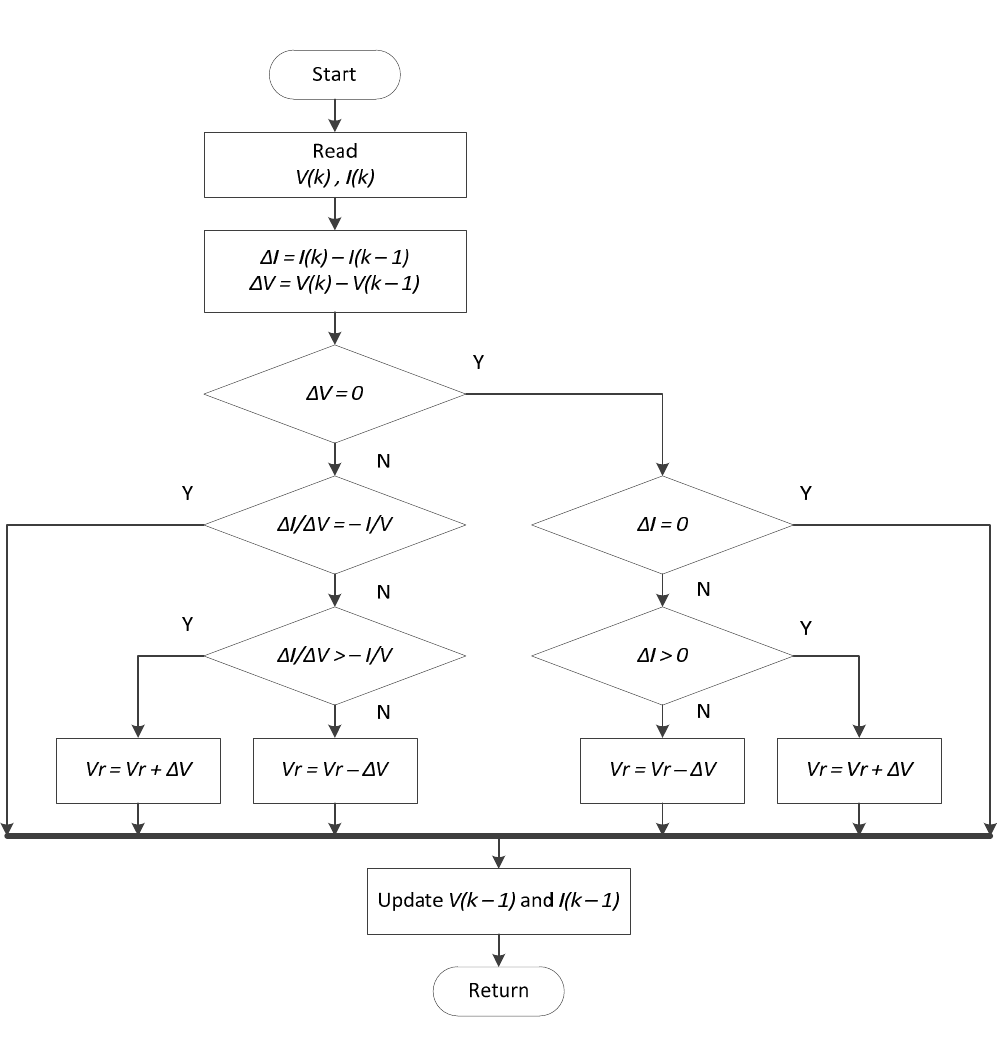
Figure 11. The flow diagram of the INC method.